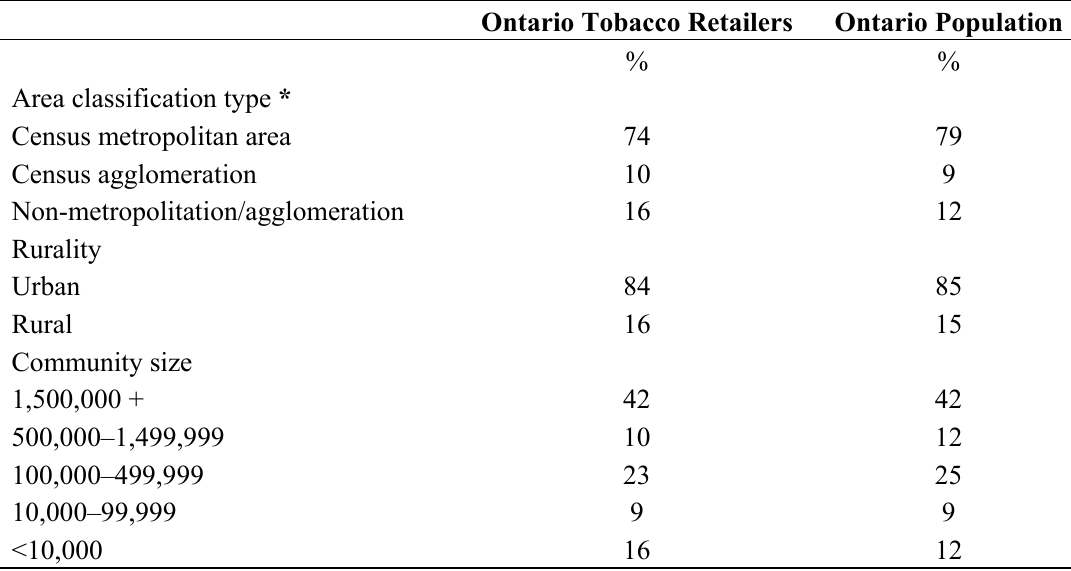
Table 1. Distribution of Tobacco Retail Outlets compared to the Ontario